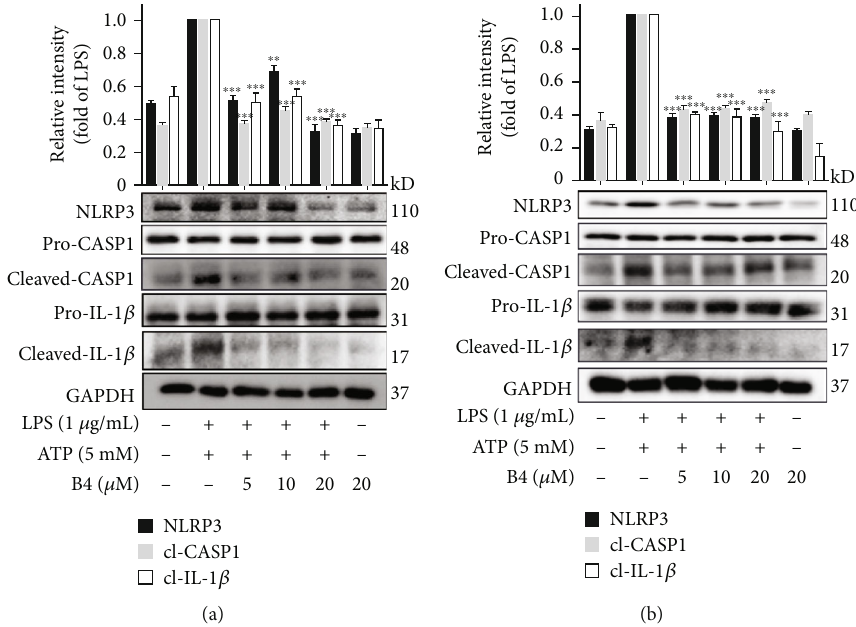
Figure 2: B4 suppressed NLRP3 in fl ammasome activation. (a, b) J774A.1 cells and THP-1 cells were pretreated with B4 for 4h, then cocultured with LPS (1 μ g/mL) for another 5h, and stimulated with ATP (5 mM) for 30 min. The expression levels of NLRP3, caspase-1, and IL-1 β were determined by Western blotting. All the experiments were performed three times independently. ∗∗ P < 0 : 01 and ∗∗∗ P < 0 : 001 versus LPS+ATP